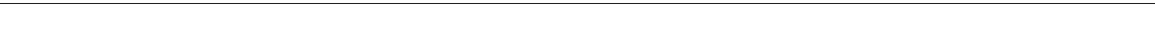
Fig. 1 Long-term in vivo imaging of cortical L4 neurons in neonates. a Schematic drawing of the in vivo time-lapse imaging between P3 and P6. IUE in utero electroporation. b A very light (~20 mg) and small (7 × 2 × 0.5 mm) titanium bar was used. c Representative image of pups (at P6) used for 3-d-long imaging (time-lapsed (TL) pups) (arrows). During imaging intervals, TL pups received maternal care with other littermates. d Representative Z-stack images of Supernova-RFP-labeled L4 neurons (magenta) and EGFP signals in TCA-GFP Tg mice. e Higher-magni fi cation images of the neuron shown in ( d ) (square). A anterior, M medial. f Basal dendrites (BDs: black), apical dendrite (AD: red), and axon (blue) of the neuron were traced and reconstructed in three dimensions. Barrel map (green) determined by EGFP signal was shown (see Supplementary Fig. 1c). g – i Another set of representative case corresponding to ( d – f ). j Body weight change of TL ( n = 6) and control ( n = 29) pups (mean ± SEM (dense) and individual (faint)). P3 L -TL vs. P6 L -TL: p < 0.001, g = 4.369, Paired t -test. P6 L -TL vs. P6 L -control: p = 0.312, g = 0.348, Welch ’ s t -test. k Barrel fi eld areas were measured in tangential sections prepared from TL pups ( n = 7) immediately after P6 L imaging. As controls, normal pups at P3 L ( n = 5) and P6 L ( n = 5) were used. P3 L -control vs. P6 L - control: p < 0.001, g = 6.131; P3 L -control vs. P6 L -TL: p = 0.001, g = 2.913; P6 L -control vs. P6 L -TL: p = 0.995, g = 0.003; Welch ’ s t -test with Holm ’ s correction. l Increase of total BD length of TL pup L4 neurons during 3-d-long imaging ( n = 51 neurons from eight mice). Mean± SEM (dense) and values of individual neurons (faint) were shown. m Total BD length of L4 neurons of TL ( n = 36 neurons from six mice) and control ( n = 9 neurons from two